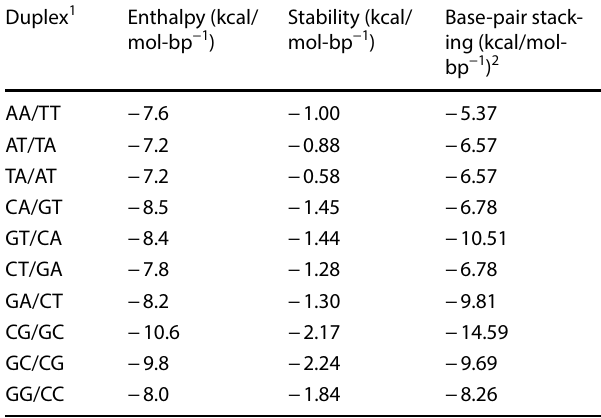
Table 2 Enthalpy, free-stability, and base-pair stacking dinucleo- tide values [23,